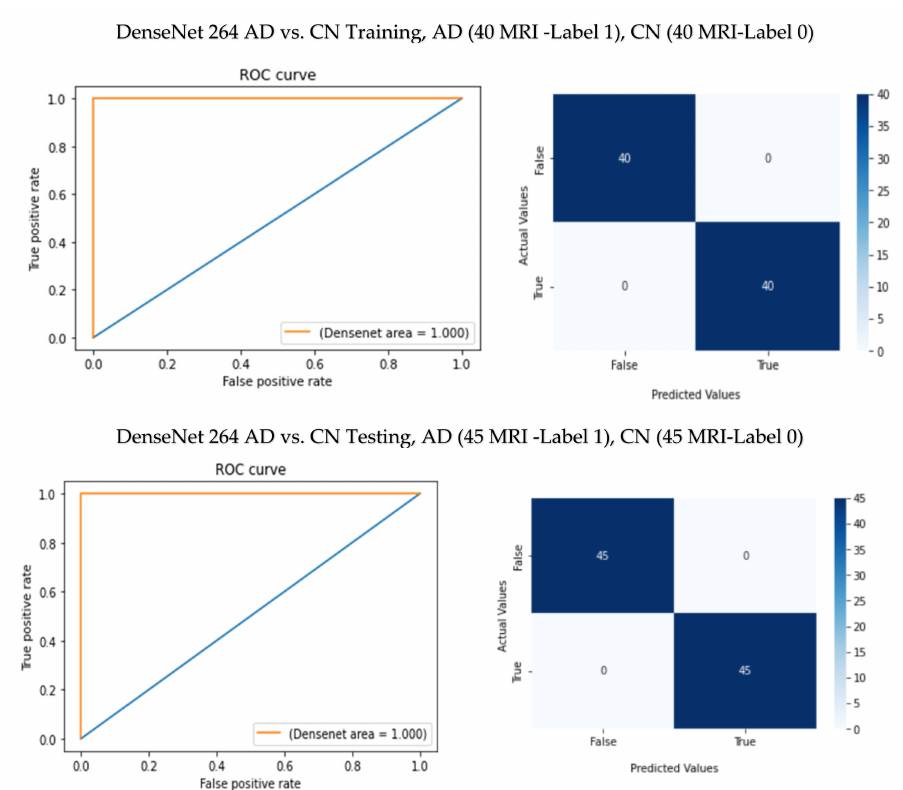
Figure 5. Confusion matrix and ROCAUC for DenseNet264’s best fold of AD vs. CN classification.